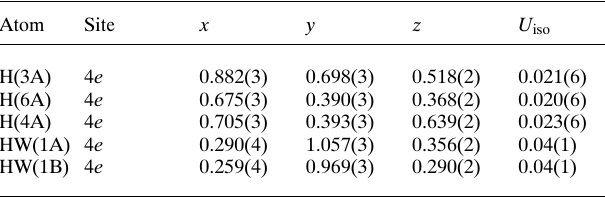
Table 2. Atomic coordinates and displacement parameters (in Å 2 )